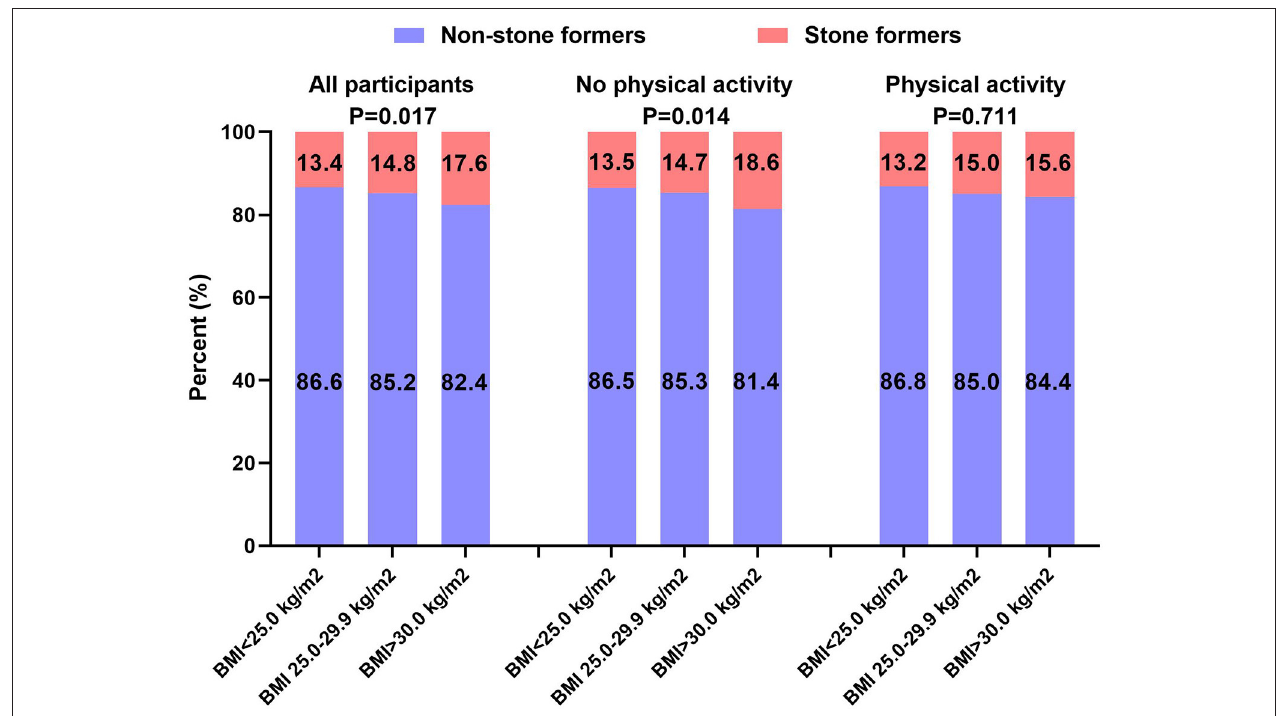
FIGURE 2 | Prevalence of kidney stones in different BMI groups among different physical activity groups.